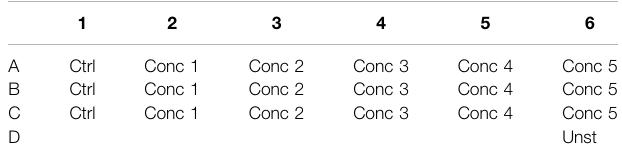
TABLE 3 | Treatment example. TABLE 4 | Plate con fi guration for cell viability